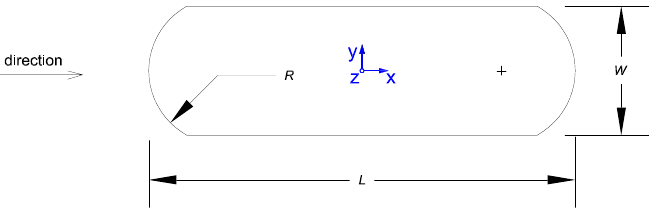
Figure 3. Geometry of the oblong bridge pier